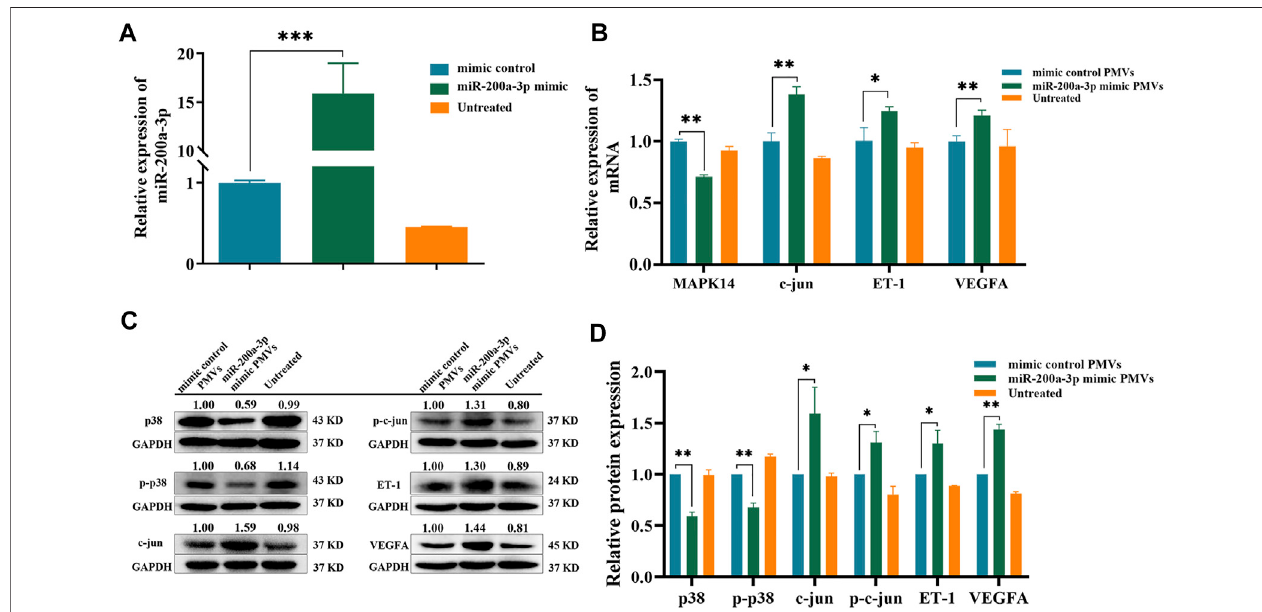
FIGURE 7 | Regulation of p38/c-jun pathway by PMVs in HUVEC. (A) PMVs were isolated by ultracentrifugation after transfecting platelets with mimic control or miR-200a-3pmimic.QRT-PCRanalysisofmiR-200a-3pexpressionlevelsinHUVECtreatedwithoutPMVs(untreated)orwithPMVsfromvarioussources(mimiccontrol PMVsand miR-200a-3p mimic PMVs)for24 h. (B) MAPK14, c-jun,ET-1 andVEGFAmRNA levelsinHUVEC after treatment withor withoutPMVsfromvarioussources were determined by qRT-PCR. (C) Western blot analysis relative expression levels of p38, phosphorylated p38, c-jun, phosphorylated c-Jun, ET-1 and VEGFA protein in HUVEC treated with or without PMVs from various sources. (D) Quanti fi cation of protein results in panel C. Data were expressed as mean ± SEM. Differences between data were assessed by the student ’ s t test, * p < 0.05, ** p < 0.01, *** p < 0.001.